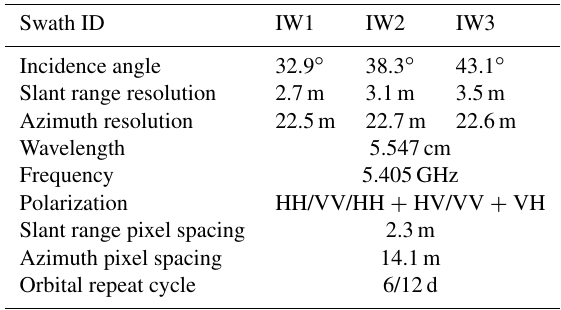
Table 1. Sentinel-1 SLC product characteristics in Interferometric Wide Swath